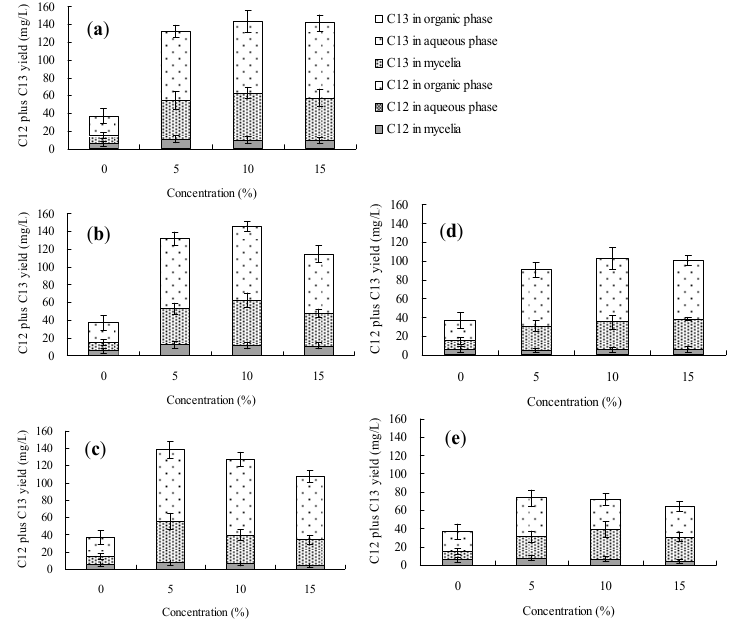
Figure 9. Effects of liquid paraffin on palmarumycin production in liquid culture of Berkleasmium sp. Dzf12. Liquid paraffin was applied at 0%, 5%, 10% and 15% on days 0 ( a ); 3 ( b ); 6 ( c ); 9 ( d ) and 12 ( e ) of culture, respectively. The period of culture lasted for 15 days. “C12” means palmarumycin C 12 , “C13” means palmarumycin C 13 . The error bars represent standard deviations from three independent samples.